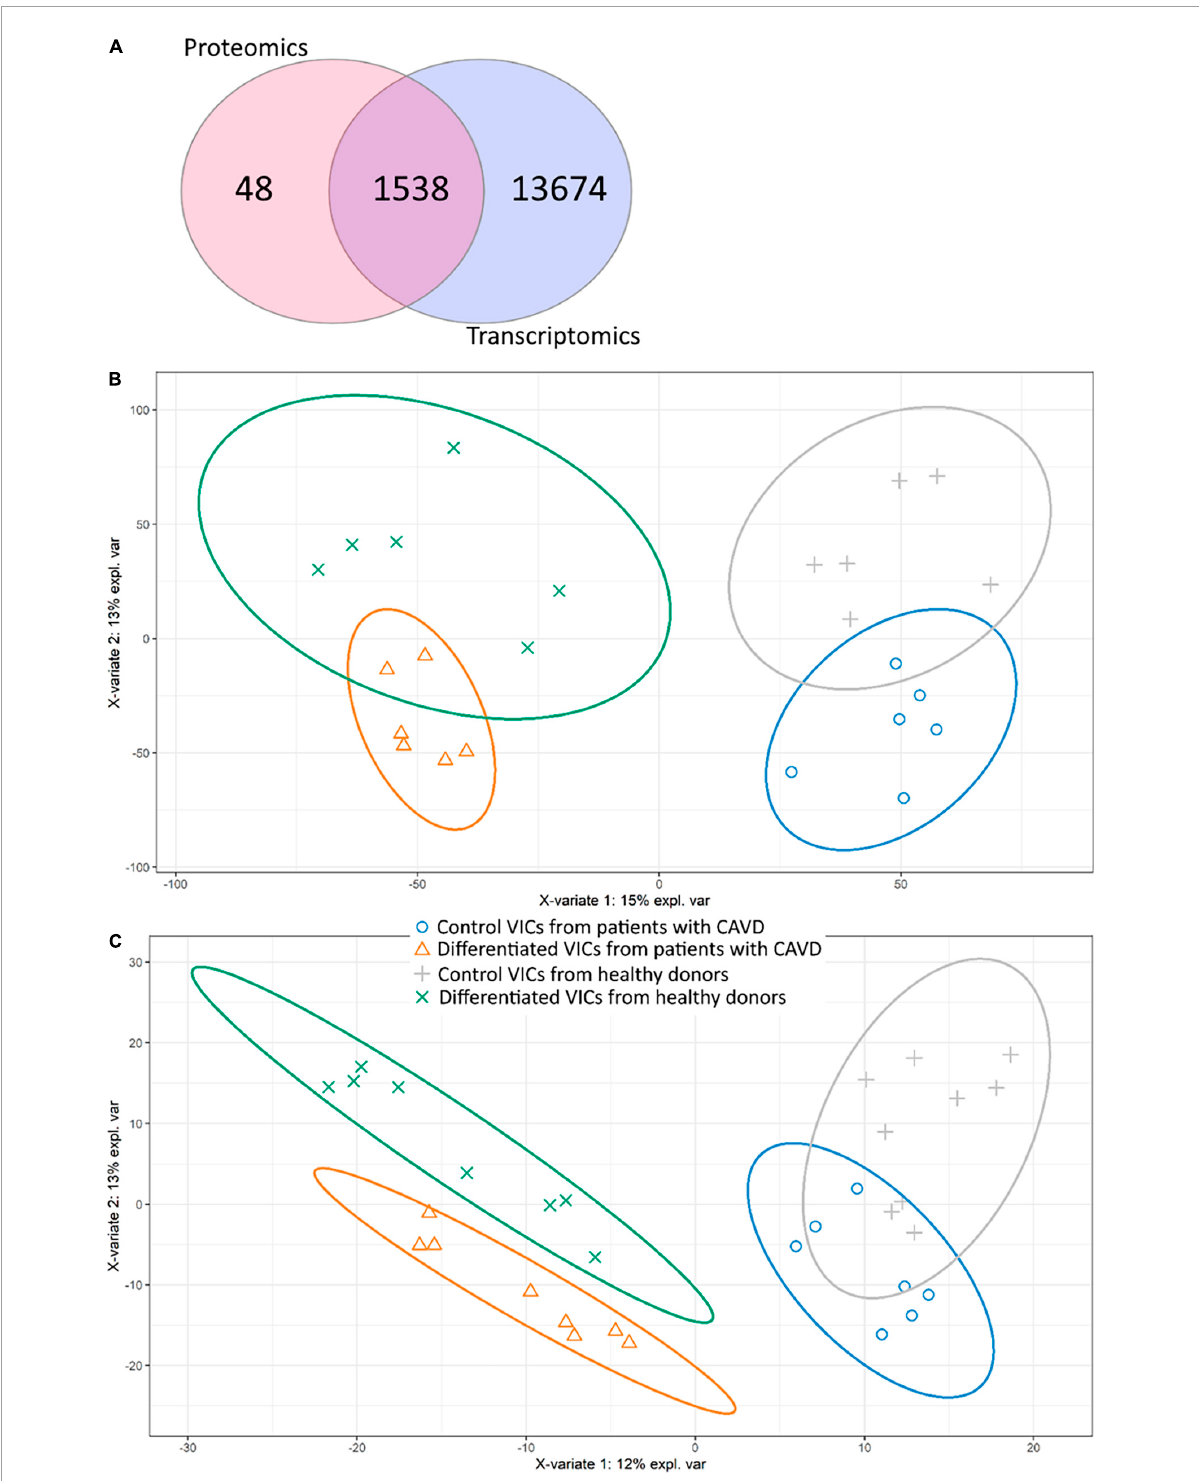
FIGURE1 Comparison of proteomic and transcriptomic profiles of human valve interstitial cells (VIC) from patients with or without calcific aortic valve disease (CAVD) in standard cultivation (control) and in osteogenic medium (differentiated). (A) Venn diagram shows the number of unique gene products identified by shotgun proteomics and RNA-seq transcriptomics. (b-c) Partial least squares-discriminant analysis (PLS-DA) score plots based on transcriptomic (B) and proteomic (C) data. Yellow triangles—differentiated VIC from patients with CAVD, green crosses—differentiated VIC from healthy donors, gray pluses—control VIC from healthy donors, blue circles—control VIC from patients with